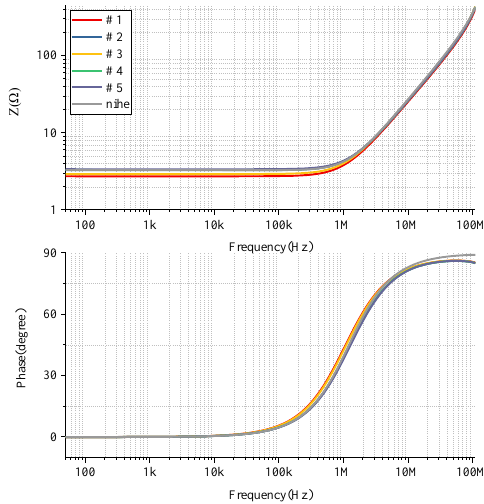
Figure 9. Comparison of impedance characteristics of the coil measured by simulation and experiment.